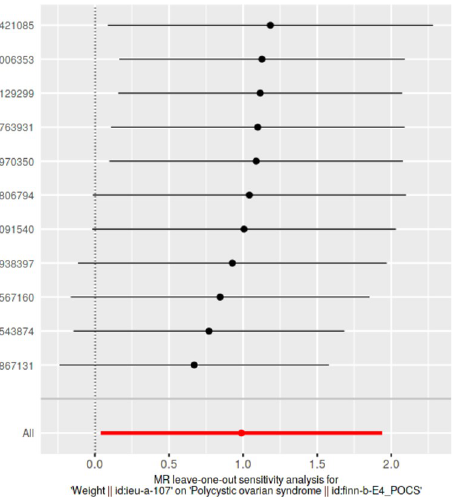
Fig 9. Leave-one-out sensitivity analysis plot of weight, against polycystic ovarian syndrome as the outcome. A given dark point indicates the effect measure from inverse variance weighted Mendelian randomization analysis excluding that specific SNP. The red lines indicate pooled analyses encompassing all SNPs via IVW-MR method (drawn for